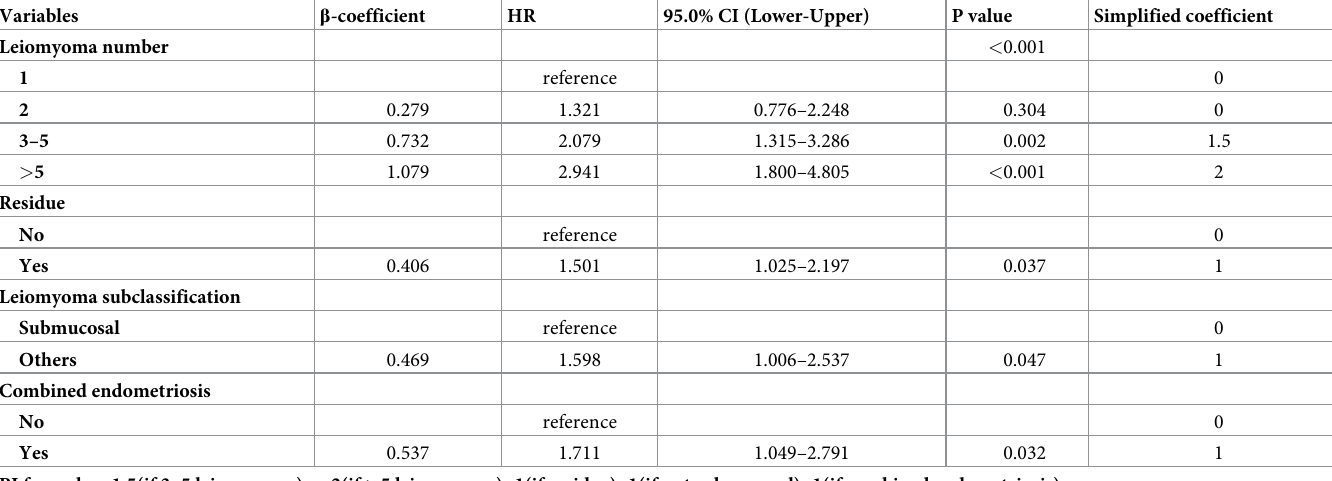
Table 2. Multivariate Cox regression analyses and the prognostic index (PI) formula based on the β -coefficients.